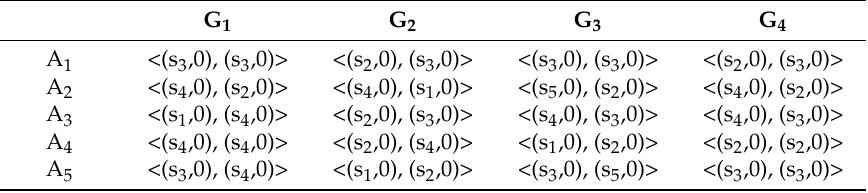
Table 2. 2TLPFN decision matrix ( R 2 )